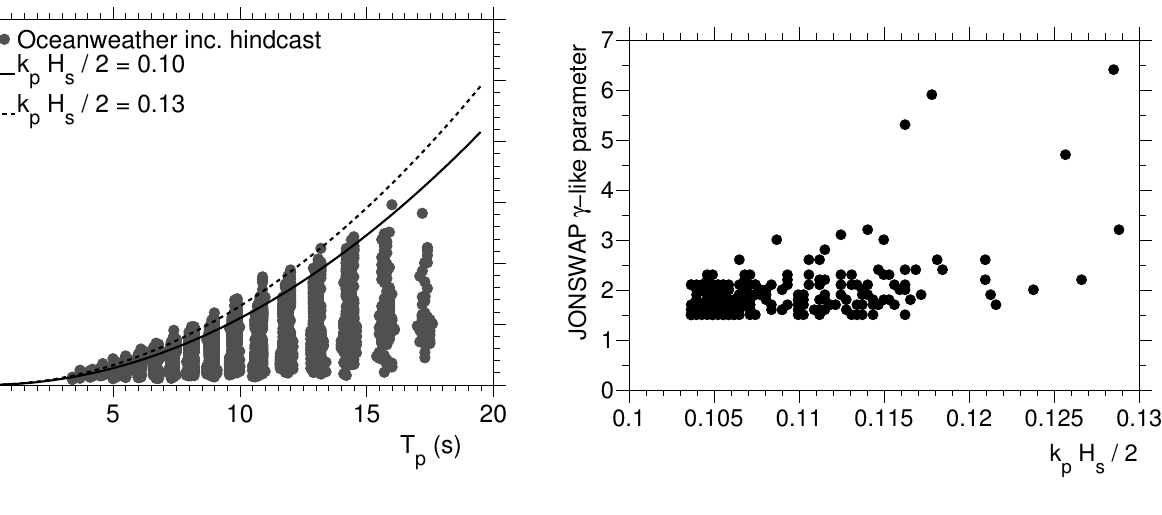
Fig. 2. JONSWAP γ -like parameter as a function of k p H s / 2 for wind seas (Oceanweather Inc.